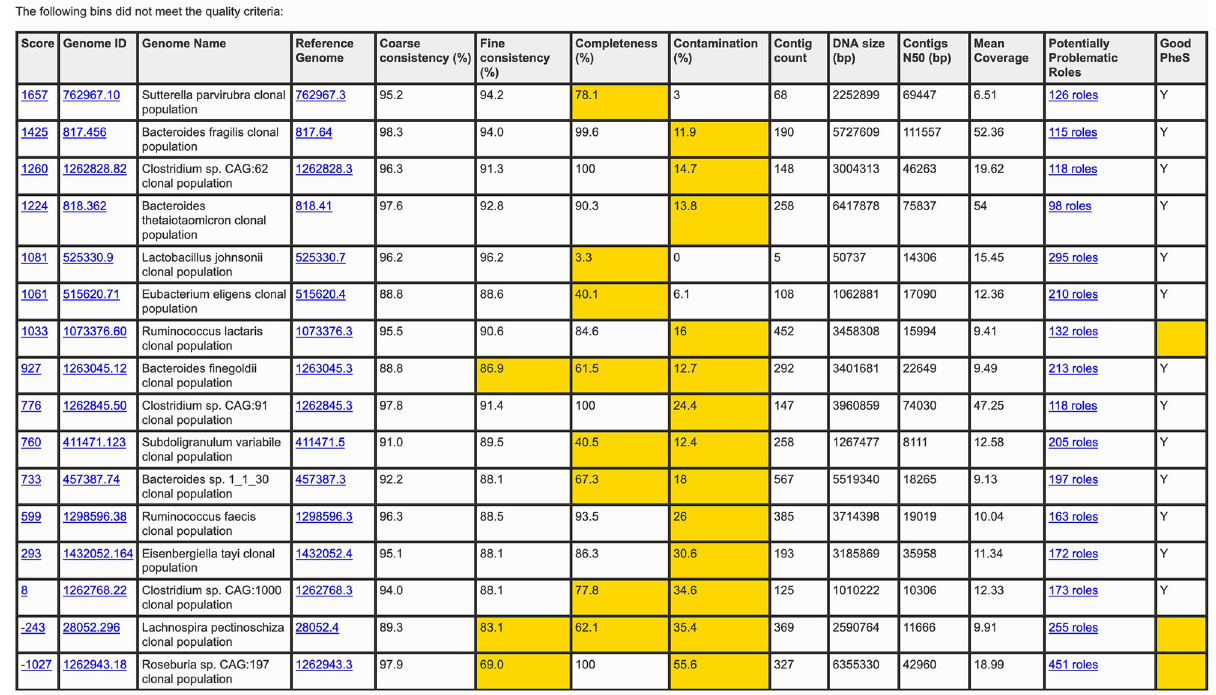
Fig 3. Metagenomic binning report for other bins. The second part of the generated binning report lists the low-quality bins found. The columns are the same as for the high-quality bins, but any metrics that fail to meet the criteria for a high-quality bin are highlighted in yellow. This gives researchers a starting point into identifying what may have gone wrong in the assembly, binning, and/or annotation process.